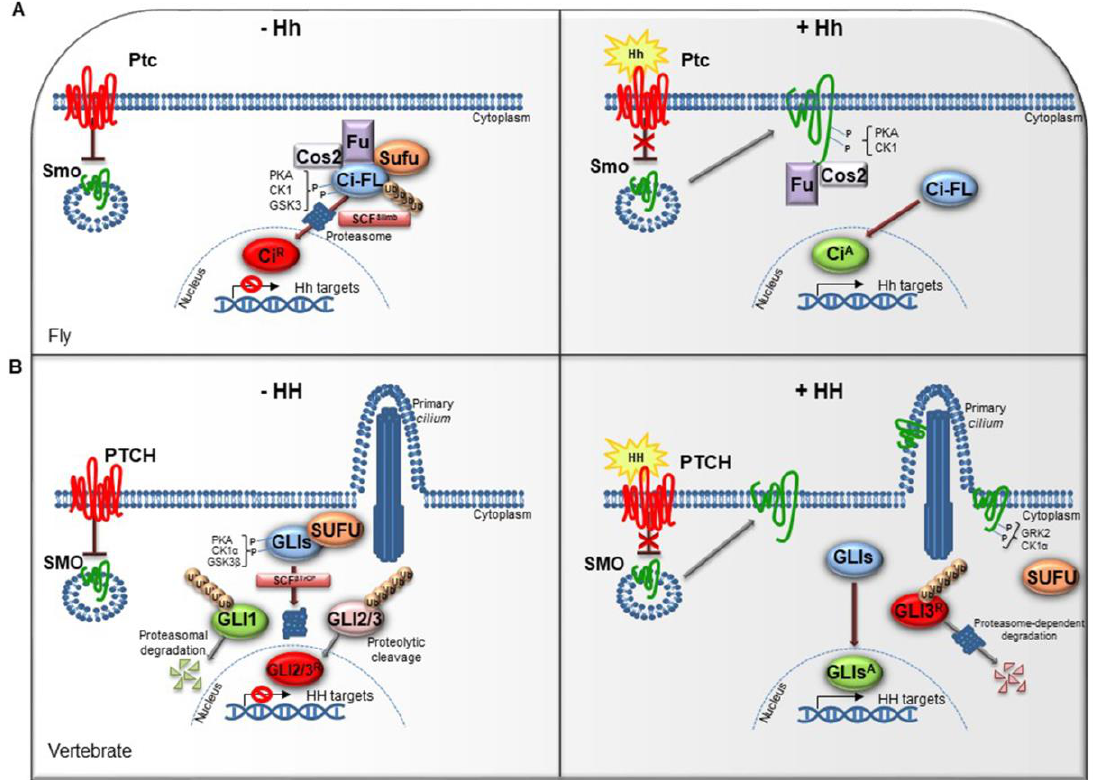
Figure 1. The Hedgehog signaling pathway. ( A ) The Hedgehog signaling pathway in fly. In absence of Hh, Ptc inhibits the localization of Smo on cell membrane. In the cytoplasm, Cos2, Fu and Sufu assemble in complex with Ci-FL protein, favoring its phosphorylation by PKA, CK1, and GSK3. This event induces the Ci-FL ubiquitylation by SCF Slimb E3 ligase thus leading both to proteasome degradation and cleavage into truncated repressor form (Ci R ). Ci R blocks the transcription of Hh target genes. On the contrary, in the presence of Hh ligand, Ptc releases the inhibitory e ff ect exerted on Smo which is activated by PKA and CK1 phosphorylation on the C-terminal domain, and then bound by Cos2 and Fu. These processes culminate in the Ci activation, promoting Hh transcription. ( B ) The Hedgehog signaling pathway in vertebrates. When the pathway is turned o ff , PTCH prevents the accumulation of SMO in the primary cilium . SUFU restrains GLI transcription factors in the cytoplasm where PKA, CK1 α , and GSK3 β kinases promote their phosphorylation. This process attracts the SCF β TrCP E3 ligase that determines the processing of GLI2 and GLI3 (GLI2 / 3 R ) in their repressor forms and the proteasome-mediated degradation of GLI1. In presence of HH ligand, PTCH inhibition is relieved. SMO is accumulated in the primary cilium and activated by GRK2 and CK1 α phosphorylation. GLI activator forms (GLIs A ) translocate into the nucleus and induce the transcription of HH target genes.